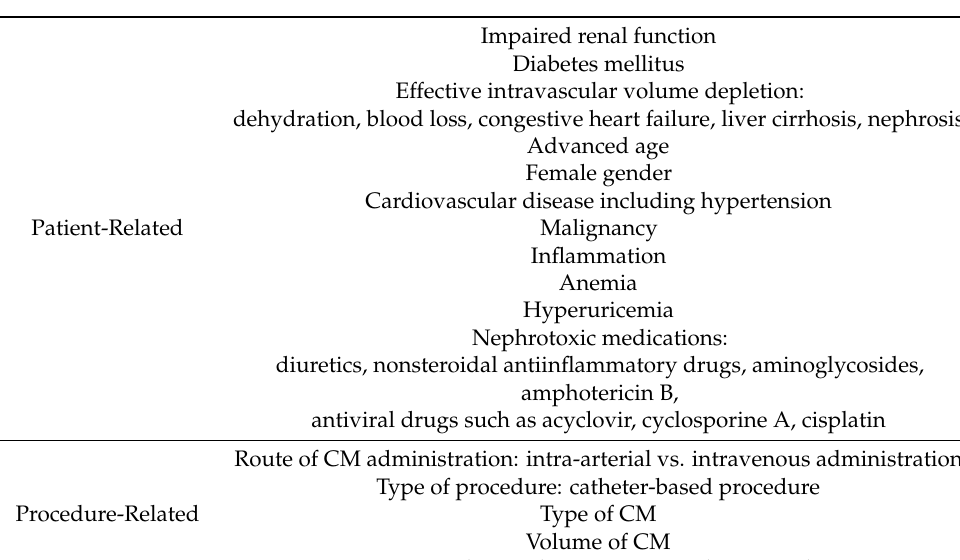
Table 1. Risk factors predisposing the development of contrast-induced nephropathy. Risk factors for contrast-induced nephropathy (CIN) can be divided into patient-related and procedure-related risk factors. Some patient-related risk factors such as volume depletion and using nephrotoxic medications are modifiable. With regard to procedure-related risk factors, the risk of CIN varies according to type, volume, and route of CM administration. Atheroembolism related to catheter manipulation and repeated CM administration also poses an increased risk of CIN. CM, contrast